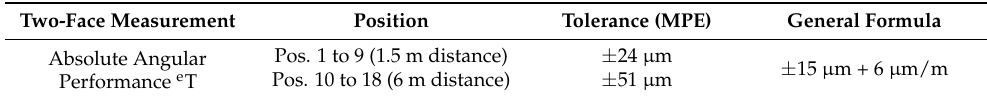
Table 2. Maximum permissible error.